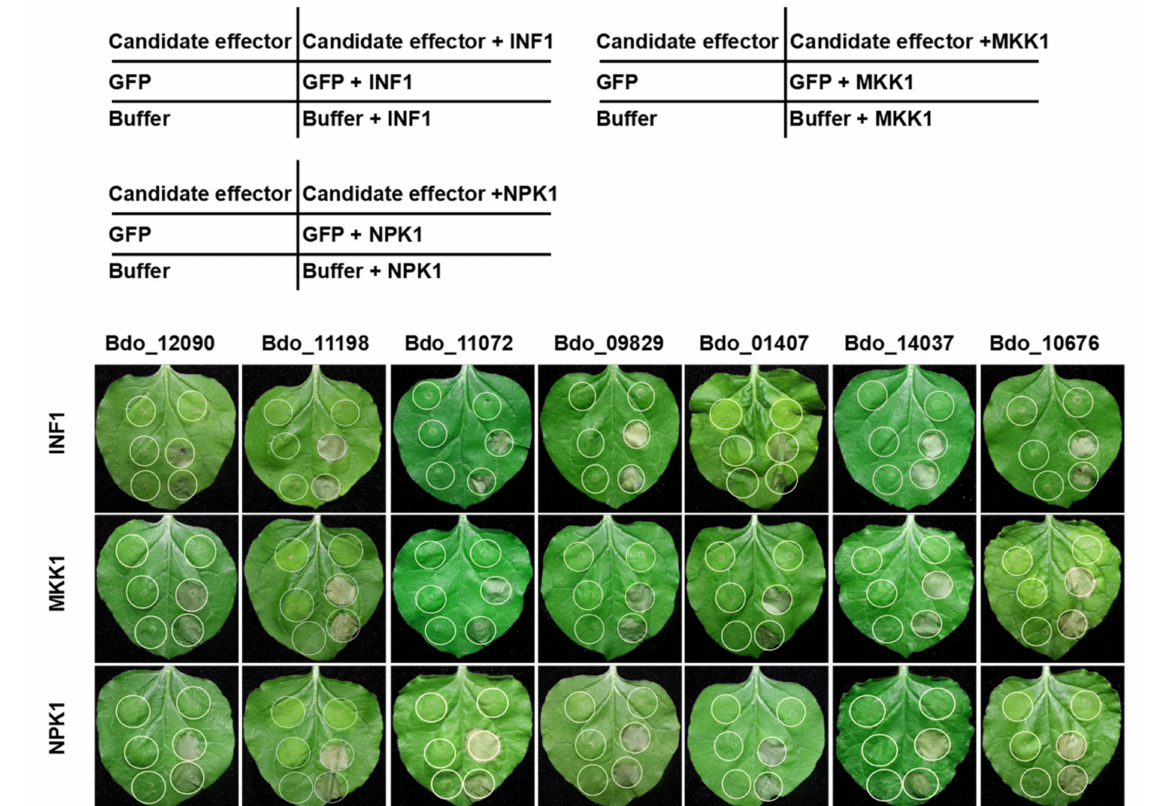
Figure 4. Transient expression of candidate effectors in N. benthamiana suppressed programmed cell death triggered by INF1, and two resistance-related mitogen-activated protein kinases (MAPKs) (MKK1 and NPK1). N. benthamiana leaves were infiltrated with Agrobacterium tumefaciens cells containing candidate effectors, GFP or Buffer (as a control), either alone or followed 24 h later by infiltration with Agrobacterium cells carrying PVX:INF1/MKK1/NPK1. Positions of Candidate effector, GFP, and Buffer in the table correspond to the infiltration sites on the below leaf photograph, respectively. 2.5. Involvement of Bdo_11198 and Bdo_12090 in the Pathogenicity of B. dothidea